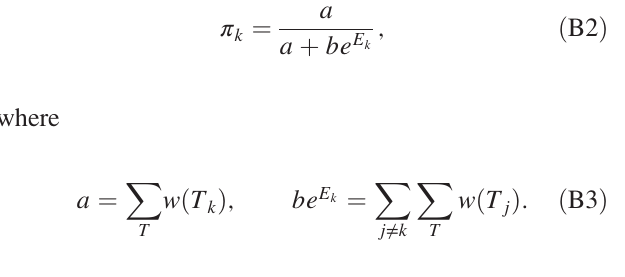
Fig. 2. Furthermore, any rooted spanning tree has exactly one edge directed out of k , unless the tree is rooted at k , in which case it has none. These observations allow us to